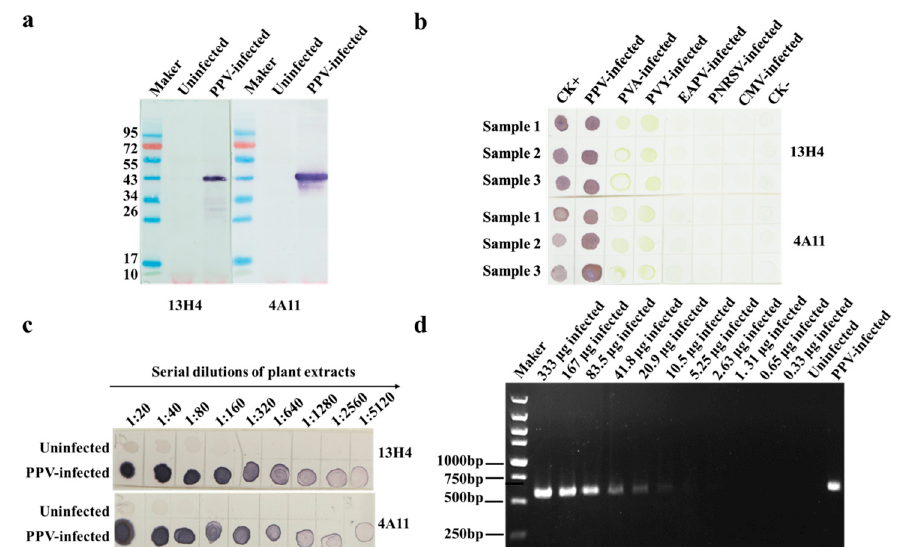
Figure 3. Specificity and sensitivity analyses of the two MAbs through Western blot assay and dot- ELISA. ( a ) Specificity analyses of the two MAbs (13H4 and 4A11) through Western blot assay using a PPV-infected and an uninfected Japanese apricot tree leaf extract. ( b ) Specificity analyses of the two MAbs (13H4 and 4A11) through dot-ELISA using crude extracts from PPV-, PVA-, PVY-, EAPV-, PNRSV-, and CMV-infected leaf samples, respectively. Known PPV-infected Japanese apricot (CK+) and uninfected Japanese apricot tree leaf tissues (CK-) were used as the positive and negative controls. ( c ) Sensitivity analyses of the two MAbs (13H4 and 4A11) through dot-ELISA. The PPV-infected and uninfected extracts were two-fold serially diluted, respectively, in the extraction buffer. Each dilution (2 µL) was loaded onto two nitrocellulose membranes and detected by the two MAbs (13H4 and 4A11), respectively. Purple dots indicate positive reactions, while green or no color dots indicate negative reactions. ( d ) Specificity and sensitivity evaluations of the one-step RT-PCR. Total RNA (30 µL) from 100 mg of PPV-infected Japanese apricot tree leaves was two-fold serially diluted from 1:10 to 1:20,480 ( v / v ) in DNase/RNase free ddH 2 O, and the diluted RNA samples (1 µL each) were used for the assay.